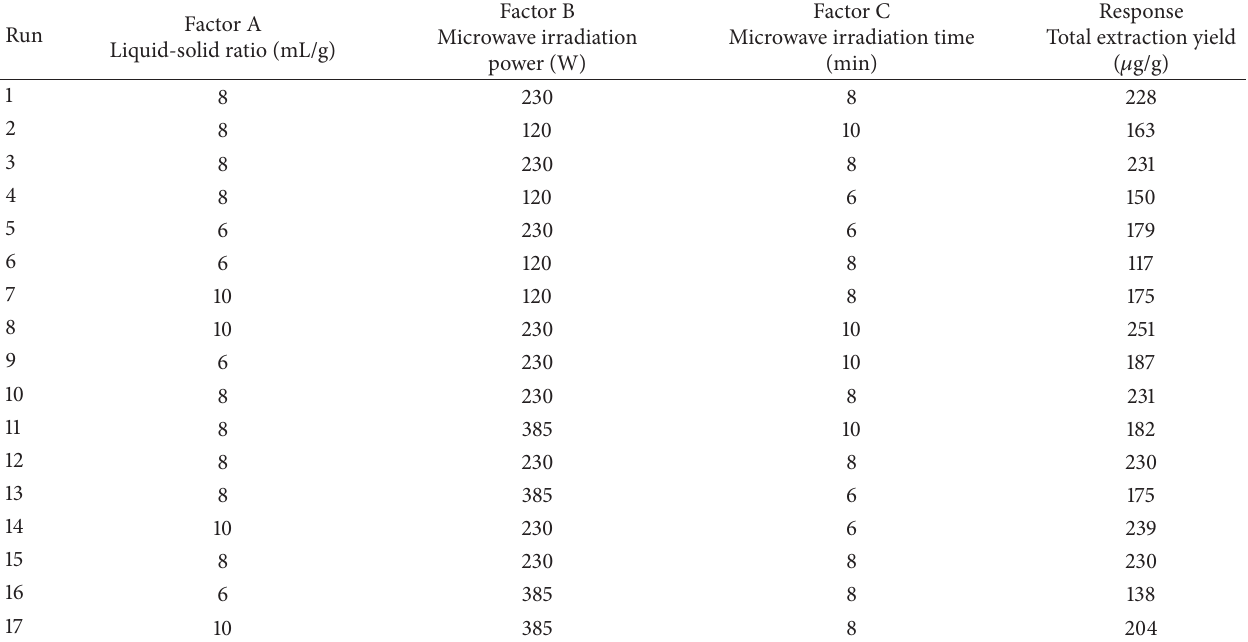
Table 1: Experimental design matrix to screen important variables for total extraction yield of luteolin and apigenin.